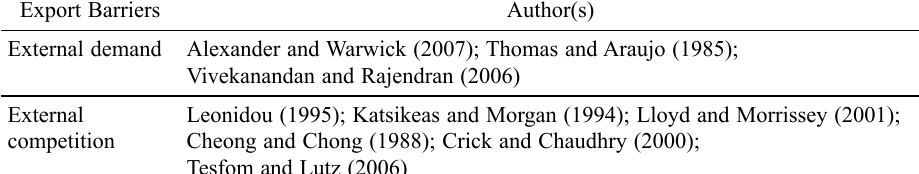
Table 1. Export barriers and related authors Export